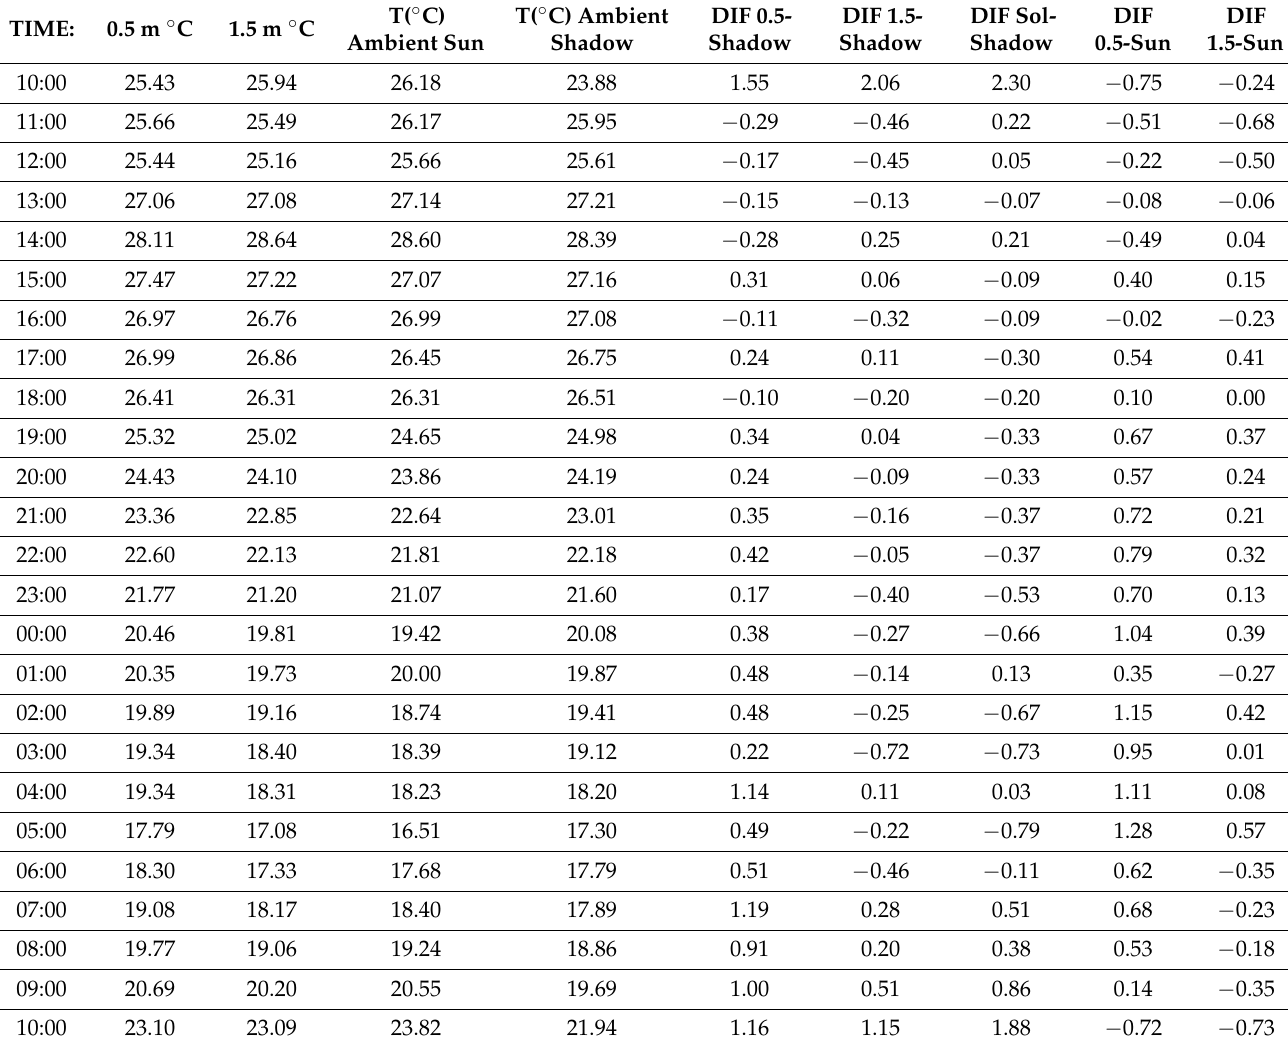
Table 4. Obtained temperatures. Date from 25–26 May